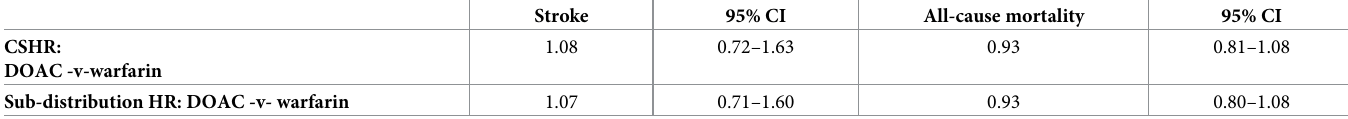
Table 5. Summary of multivariate adjusted cause-specific hazards and the subdistribution hazards for